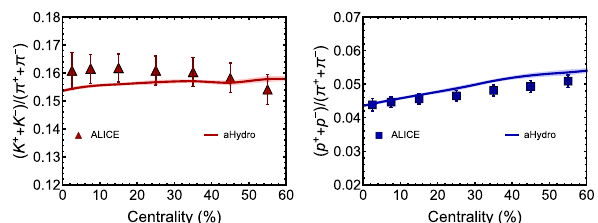
Fig. 4 Transverse-momentum integrated K /π (left) and p /π (right) ratios as a function of centrality measured in Pb–Pb collisions at 5.02 TeV. Solid lines are predictions of aHydroQP model where sym- bols with error bars are experimental data from Ref. [69]